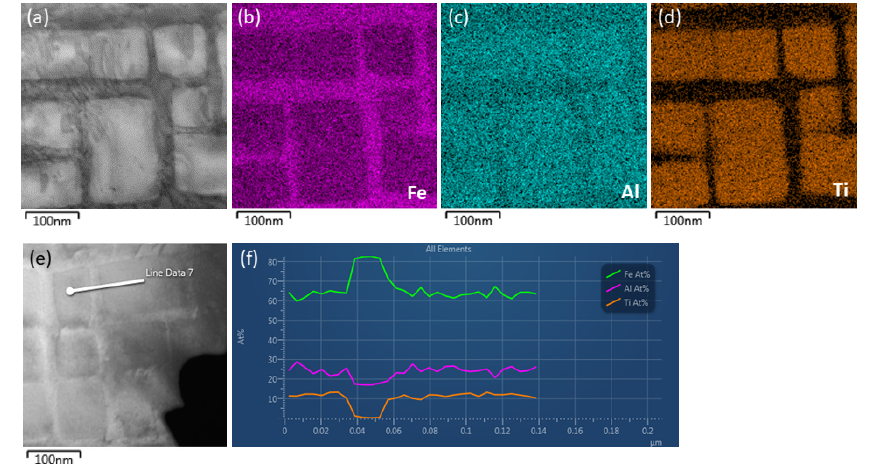
Figure 2. A transmission electron microscope (TEM) micrograph ( a ) showing the superalloy nano-structure in our Fe 71 Al 22 Ti 7 sample. The corresponding chemical composition ( b – d ) as detected by the Energy-Dispersive X-ray (EDS) spectroscopy in the same spot of our TEM lamellae. The analysis is accompanied by one of our line-scans ( e ) together with the corresponding chemical profile ( f